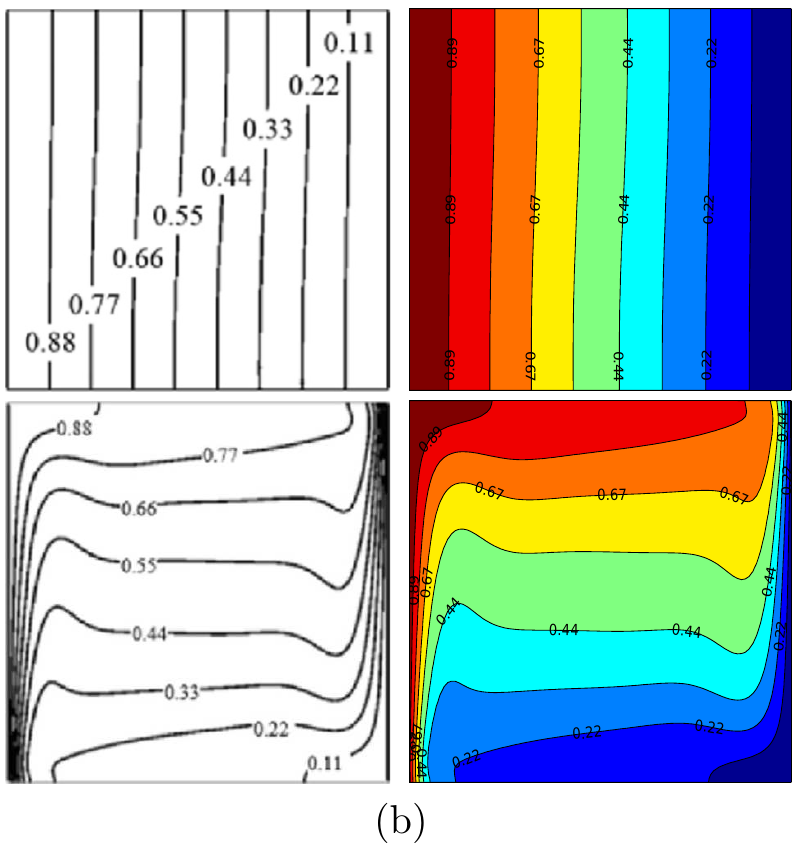
Figure 4. Streamlines ( a ), Motlagh and Soltanipour [19] ( left ), present study ( right ); isotherms ( b ), Motlagh and Soltanipour [19] ( left ), present study ( right ) for Ra = 10 2 ( top ) and Ra = 10 6 ( bottom ) at φ = 0.02 and D = 0.